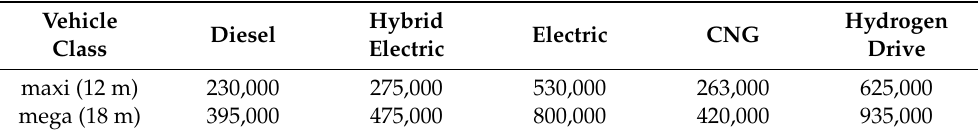
Table 4. The average cost of purchasing a city bus, taking into account the type of drive and capacity ( € ).